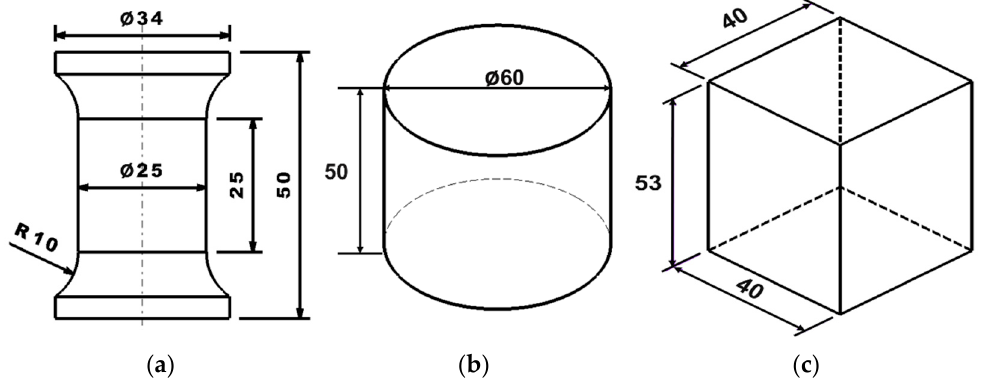
Figure 1. Foam blocks (Synbone, Zizers) with different density of: ( a ) 0.14 g/cm 3 ; ( b ) 0.35 g/cm 3 .